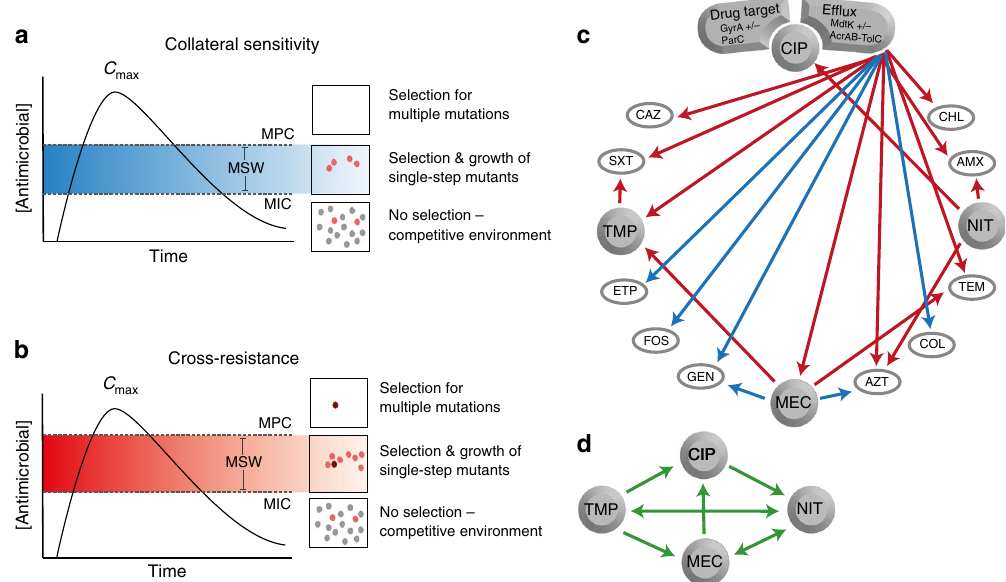
Fig. 4 Presentations of the potential effects and implications of CS and CR. a Sequential drug administration informed by CS (blue) could potentially narrow or shift the mutant selection window (MSW) downwards in concentration space whereas ( b ) CR (red) results in a widened or shifted upwards mutant selection window for secondary antimicrobials. This would affect the probability of acquiring second-step mutations leading to high-level resistance. Consequently, CS-informed secondary therapies could reduce selection and thus propagation of fi rst-step mutants resulting in a reduced opportunity for second-step mutations to occur. Dots represent bacteria resistant to a primary antibiotic (gray), spontaneous mutants with reduced susceptibility to a secondary drug (pink), or those with high-level resistance to the secondary drug (dark red). Note that these are hypothetical schematics and in many cases the maximum concentration achieved ( C max ) may be below the MPC. c Arrows indicate conserved collateral responses, where CS (blue) and CR (red) are depicted. The collateral responses in this study are mainly predicted by ef fl ux-related mutations in the cipro fl oxacin-resistant mutants. These data suggest potential secondary treatment options that may reduce the rate of resistance evolution ( a , b ) following initial treatment failure. d Green arrows indicate putative temporal administration of four antimicrobials used for the treatment of urinary-tract infections, as informed by the collateral networks in ( c